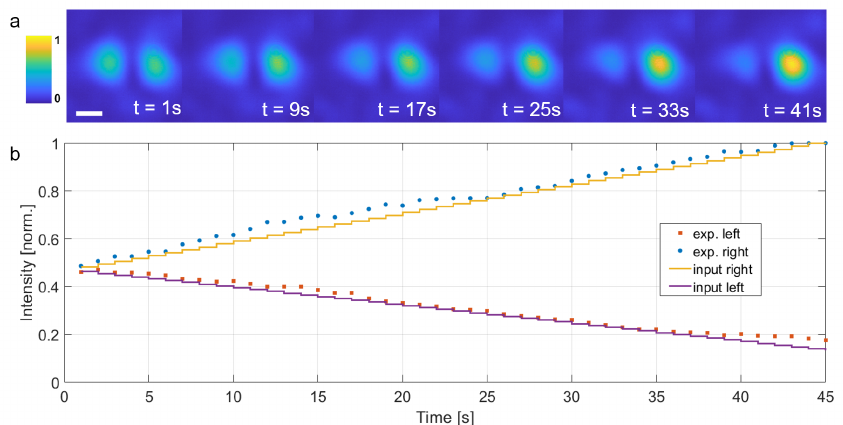
Figure 5. ( a ) Intensity modulated dual-spot light field through a multi-core fiber employing Core-GS algorithm. The scale bar shows a length of 5 µ m. ( b ) Normalized mean intensity of both spots and the corresponding modulated input target